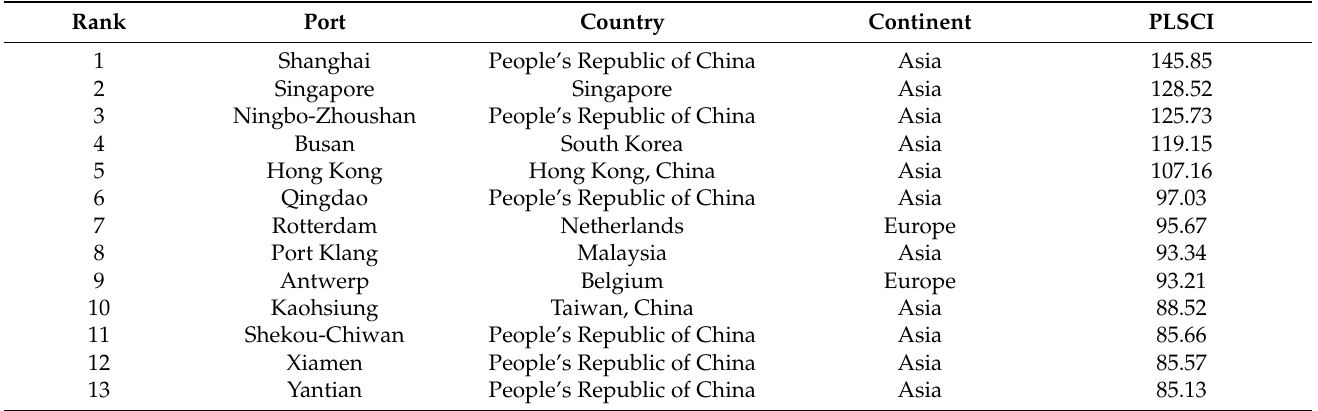
Table 6. Top 30 ports with the highest